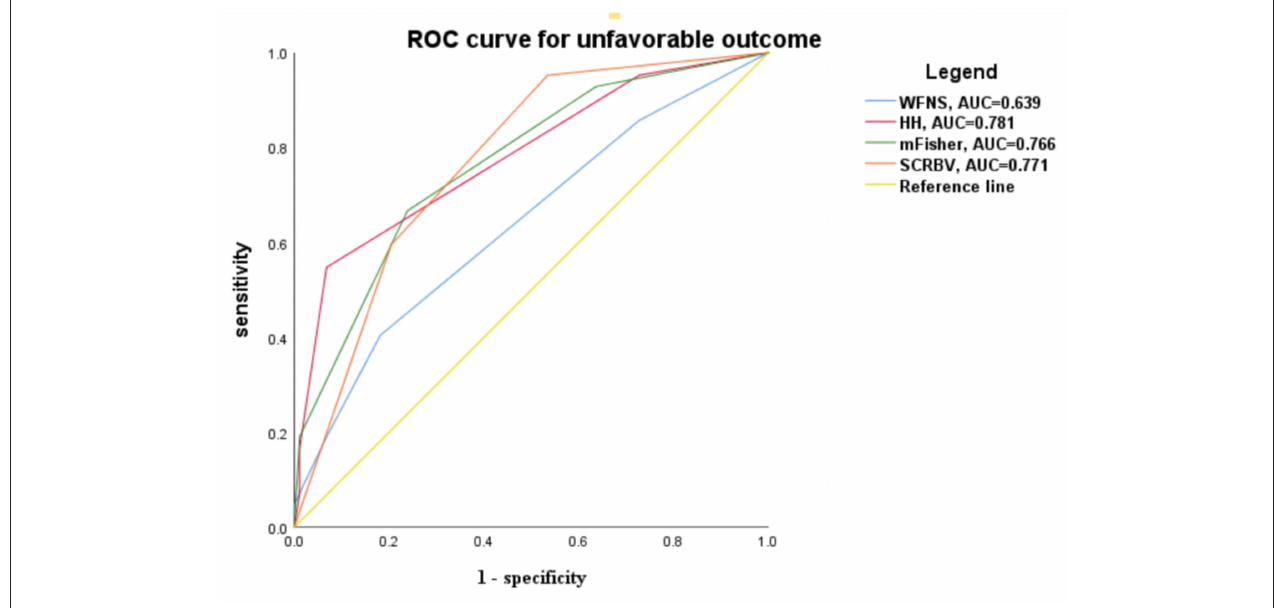
FIGURE 5 | ROC curve for predicting the unfavorable outcome according to the clinical and radiographic grades. WFNS , World federation for neurological surgeons grade; HH , Hunt-Hess grade; mFisher , modified Fisher score; SCRBV , Score of Change Rate of Brain Volume.